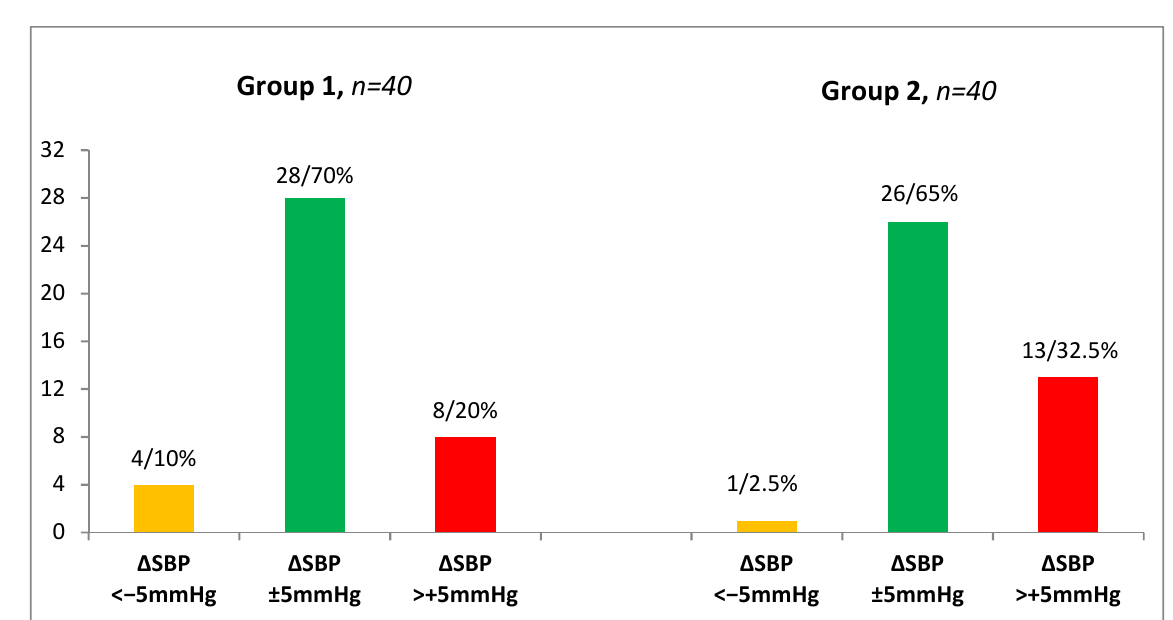
Figure 1. The personalized analysis of ΔSBP in different racial groups of young healthy adults (European participants, Group 1; African participants, Group 2) using a passive orthostatic test with a standardized hydrostatic column height. Note: orange column, “decrease” category (ΔSBP < −5 mmHg); green column, “same” category (ΔSBP ± 5 mmHg); red column, “increase” category (ΔSBP > +5 mmHg); Y -axis, the number of subjects.